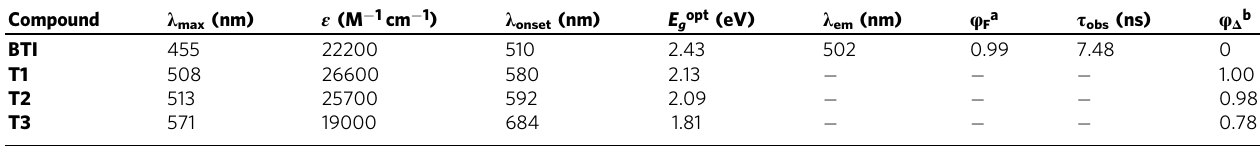
Fig. 4 Experimental and computed photophysical properties. a UV-visible spectra recorded in solution (Dichloromethane) for BTI (black line), T1 (blue line), T2 (red line), and T3 (pink line). Inset: photographs of the solutions under natural (top) and blue light (bottom) to show the absence of emissive properties of T1 − T3 . b Simulated UV-visible spectra (TD-DFT/OT- ω B97-XD/6-31 G(d,p) /Dichloromethane, ε = 8.9) for BTI (black line), T1 (blue line), T2 (red line) and T3 (pink line). c TD-DFT computed electronic structure of BTI and T1 − T3 . The variation of electron density is given for the S 0 − S 1 transition both in absorption and emission considering always S 0 as the reference state. Blue and green areas correspond to electron depletion and increase, respectively (isosurface 0.001 a.u.). The magnitude of the SOC between S 1 and the triplet states is given below the triplet state positions in cm − 1 . Table 2 Optical Data recorded at room temperature in dichloromethane for BTI, T1, T2, and T3 unless otherwise